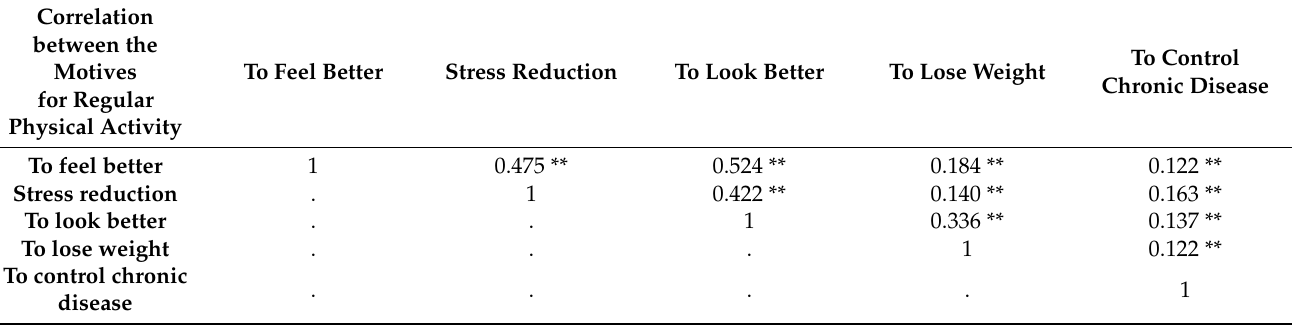
Table 9. Correlation between the motives for regular physical activity among medical students.